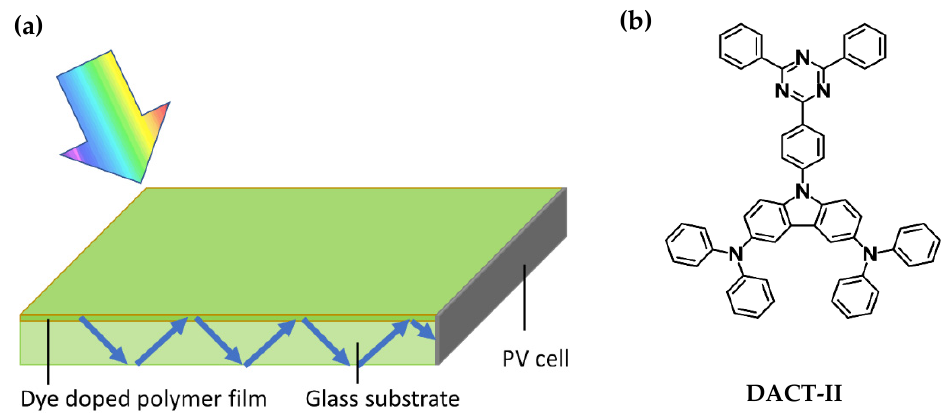
Figure 1. ( a ) Schematic representation of thin-film LSC. ( b ) Chemical structure of DACT-II employed Figure 1. (a) Schematic representation of thin-film LSC, (b) Chemical structure of DACT-II em- in our ployed in our study.